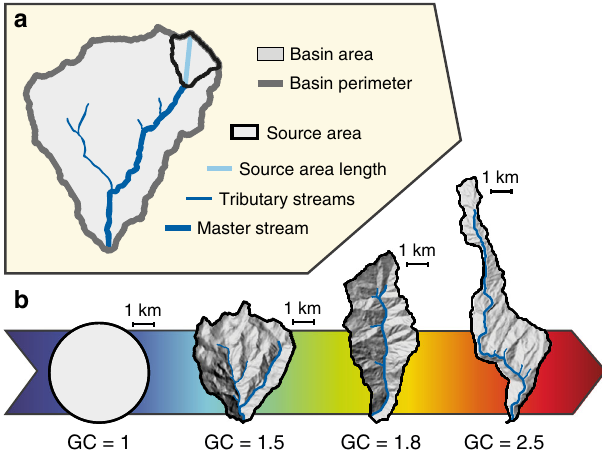
Fig. 2 Geometric parameters of a drainage network and its watershed basin. from the Bhutan dataset and associated Gravelius coef fi cients for a (GC = 1). For each basin, the thick blue line corresponds to the